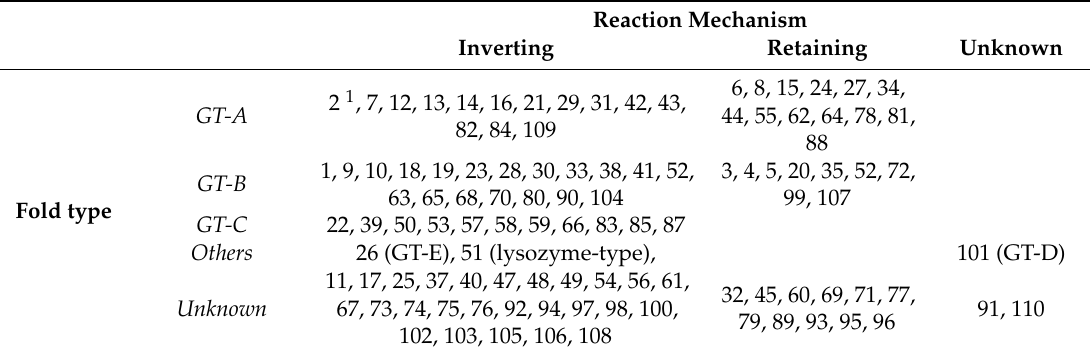
Table 1. Classification of glycosyltransferase